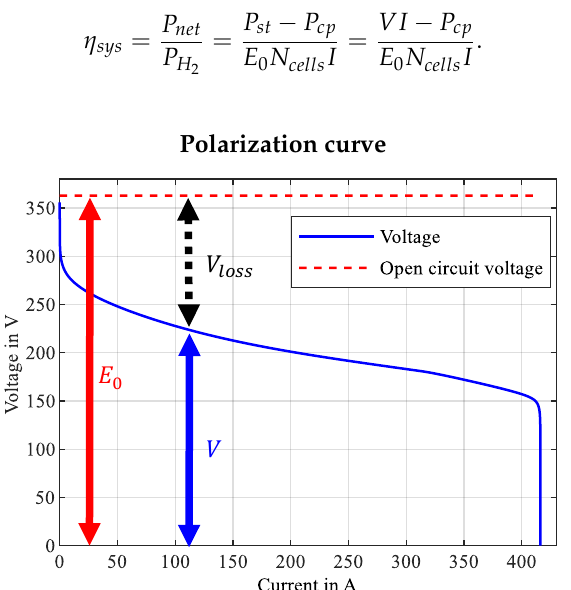
Figure 2. Polarization curve obtained by simulation. The current is ramped up from zero until voltage breakdown. The red dashed line shows the open-circuit voltage, the blue solid line shows the operating voltage. The difference between the two are the losses due to reaction kinetics (activation, ohmic, and concentration) V loss